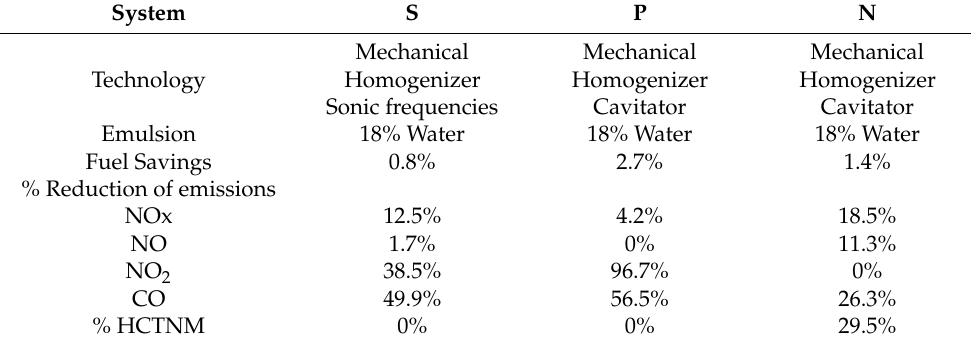
Table 9. Process model II.